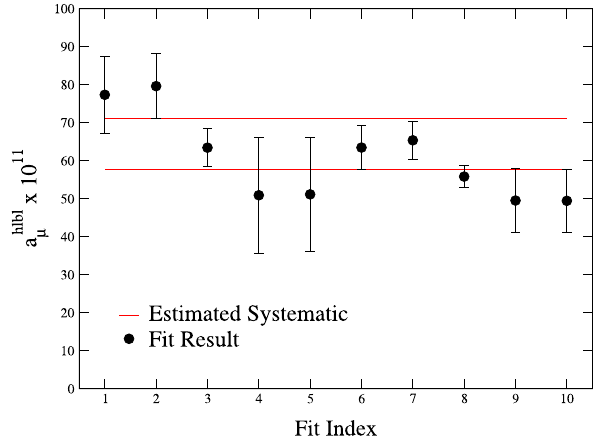
Fig. 15 An estimate of our continuum extrapolation systematic on the full a hlbl μ for the combination of method 2 and the disconnected data